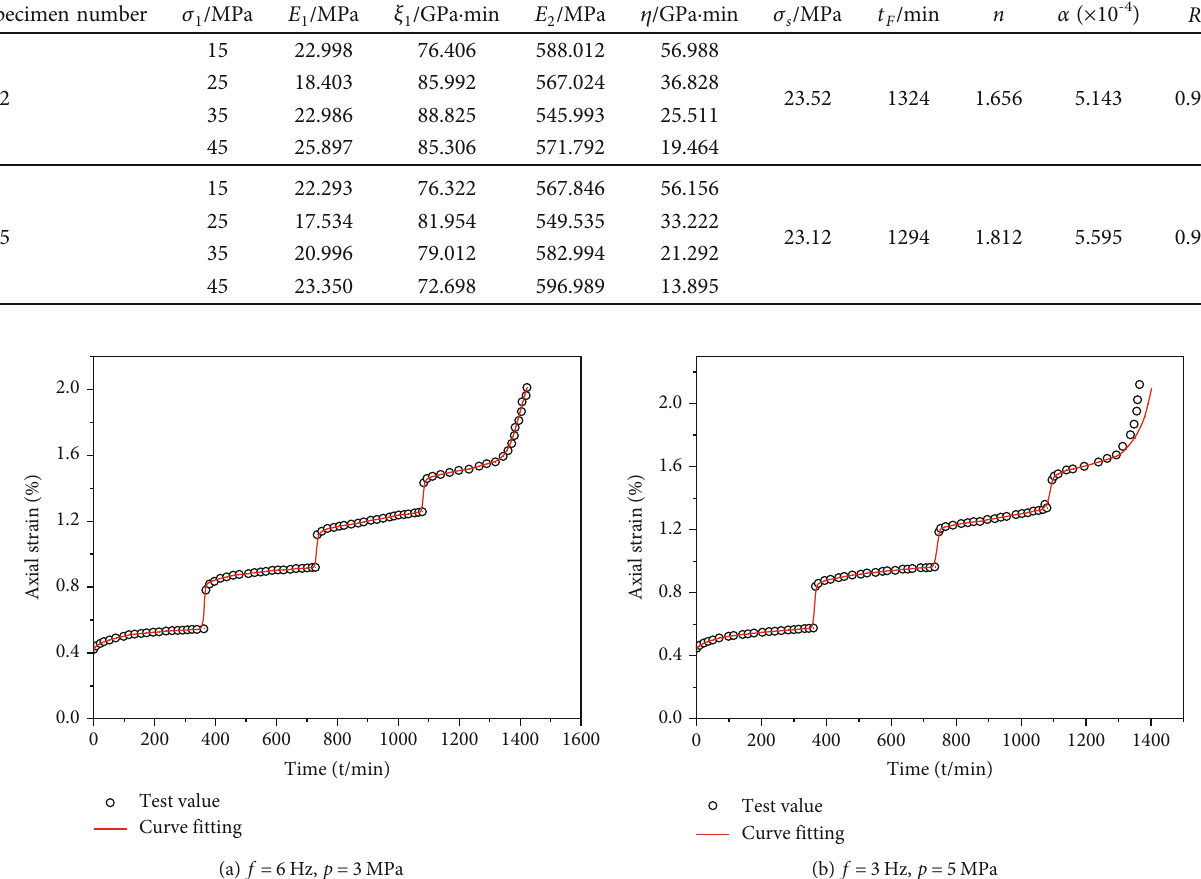
Table 3: Fitting results of shale creep damage model parameters under osmotic